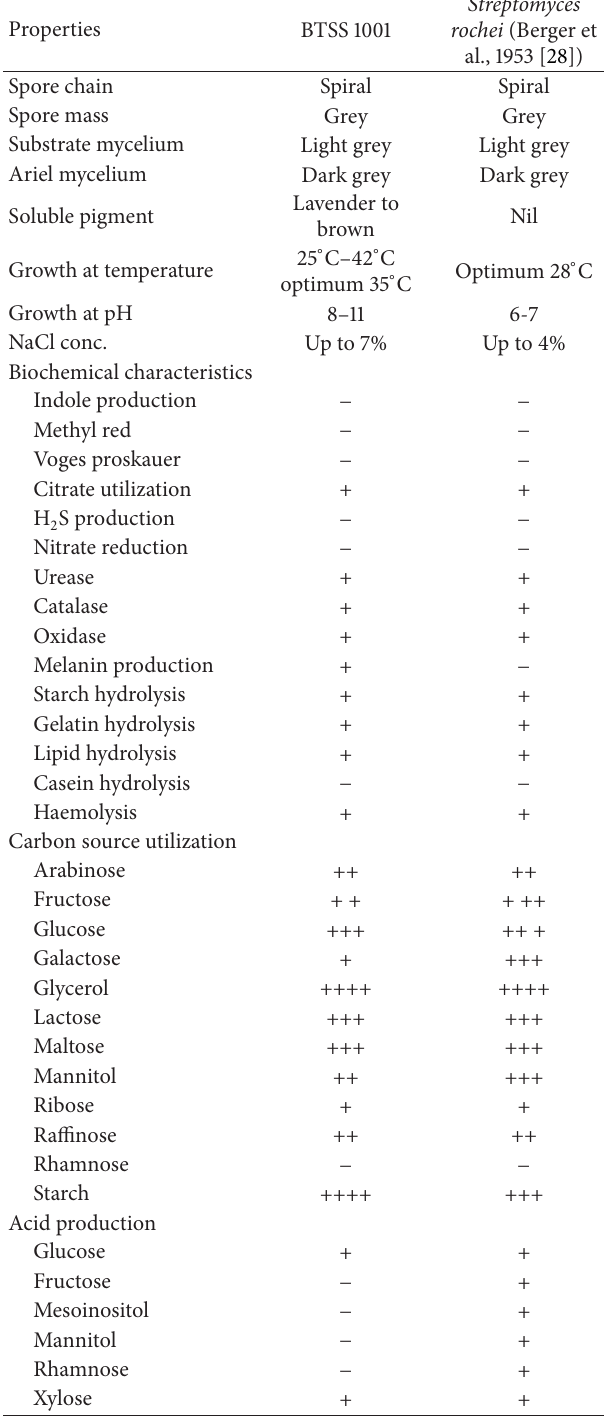
Table 3: Morphological, biochemical, and physiological character- istics of marine isolate BTSS 1001 in comparison with Streptomyces rochei (Berger et al., 1953